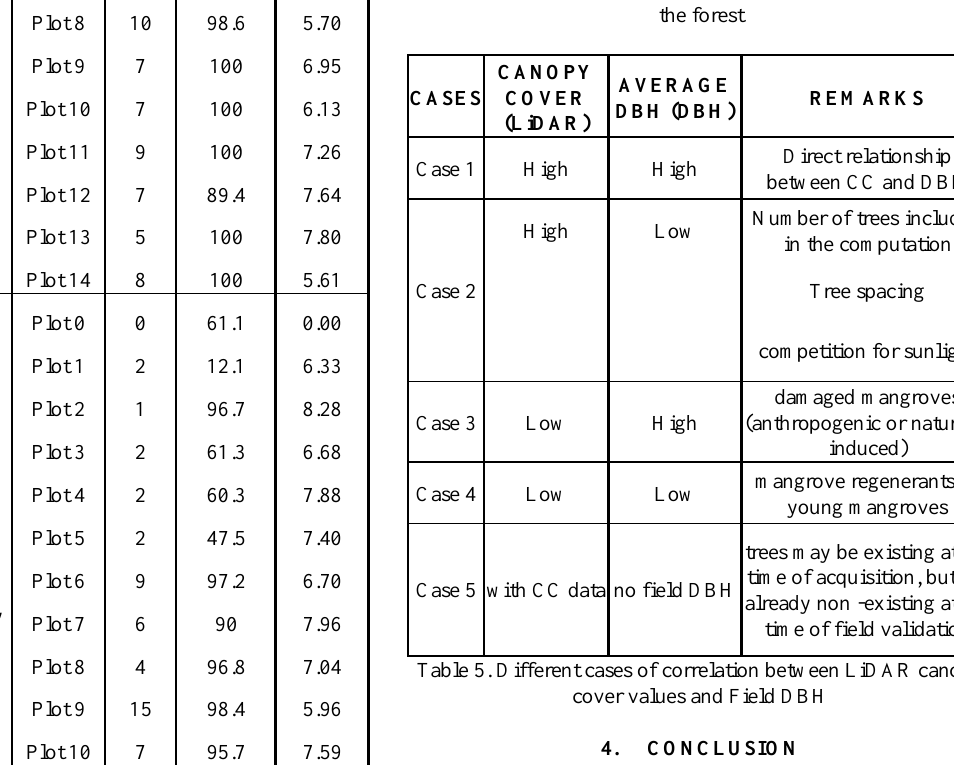
Figure 8. Linear Regression equation of the CC and DBH correlation for the sample plots located at the periphery part of